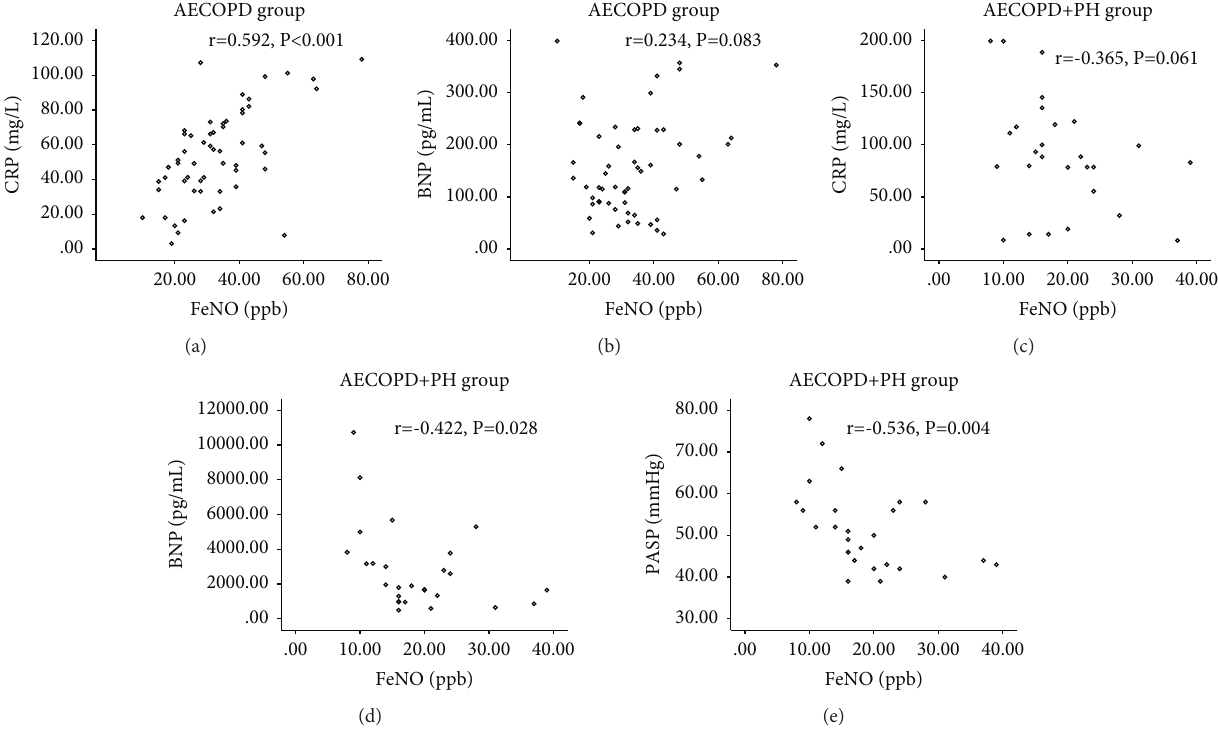
Figure 2: Relationship between FeNO vs. BNP, CRP, and PASP in AECOPD patients with or without HP. (a) Relationship between FeNO and CRP in AECOPD patients. (b) Relationship between FeNO and BNP in AECOPD patients. (c) Relationship between FeNO and CRP in AECOPD+PH patients. (d) Relationship between FeNO and BNP in AECOPD+PH patients. (e) Relationship between FeNO and PASP in AECOPD+PH patients. FENO, fractional exhaled nitric oxide; PH, pulmonary hypertension; BNP, brain natriuretic peptide; CRP, C- reactive protein; PASP, pulmonary arterial systolic pressure.